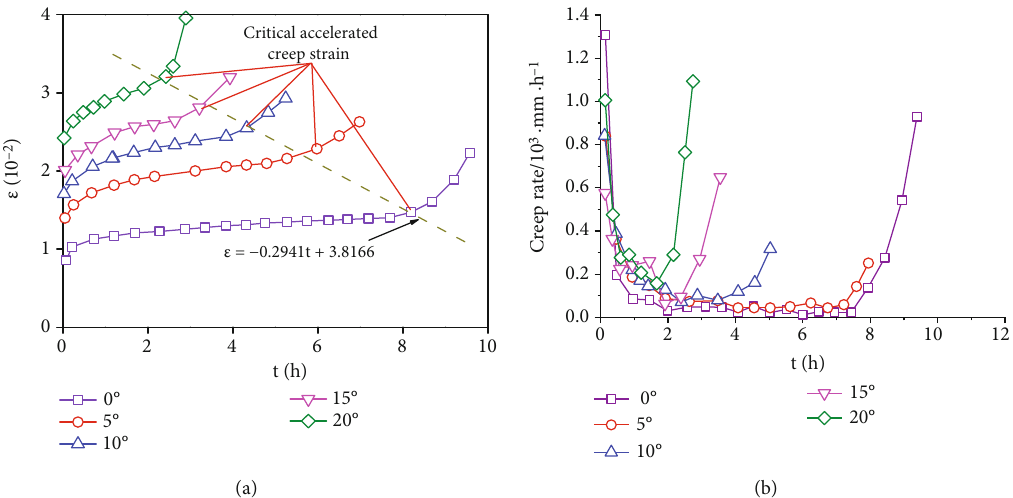
Figure 9: Axial strain-time creep curve and deformation rate of coal specimens for stress loading level of 95% σ